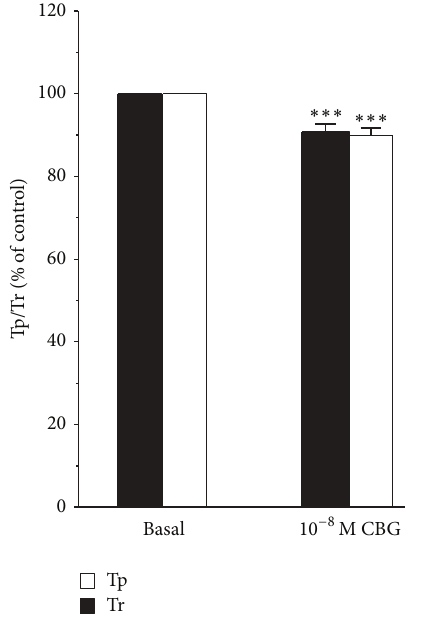
Figure 8: Summarized data for the effect of CBG on Tp and Tr for myocyte shortening. Changes in timing were measured in milliseconds and normalized to changes in the peak amplitude. Data are presented as means ± S.E.M. ( 𝑛 = 7 –9 cells). ∗∗∗ 𝑃 < 0.001 , compared with